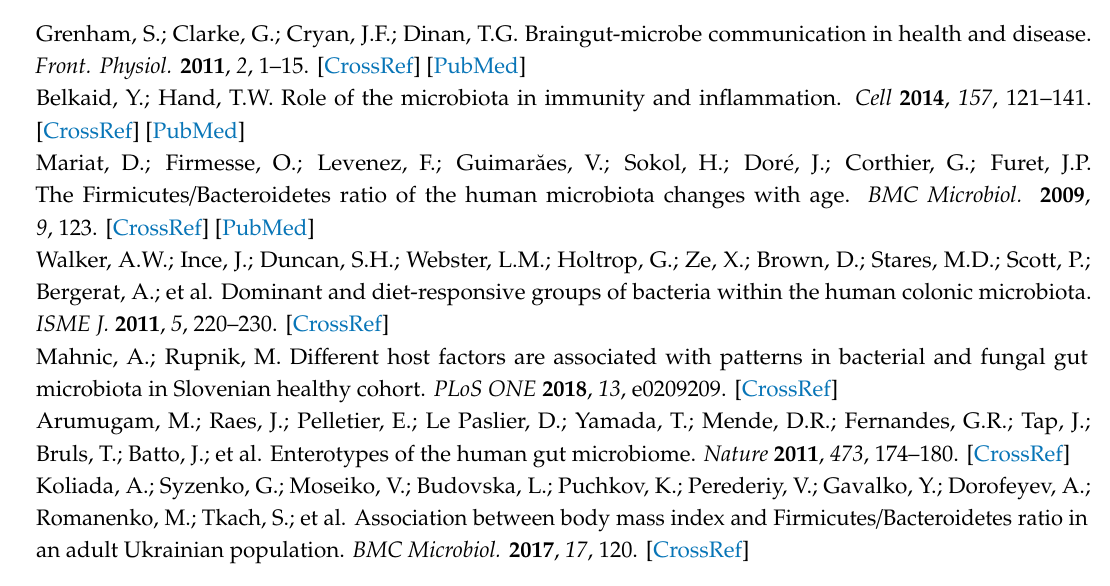
Table S1: Mean abundance values ± SD of bacterial genera from fecal samples categorized per BMI category of participants. * p < 0.05, Table S2: Mean abundance values ± SD of bacterial genera from fecal samples categorized per MD score of participants. * p < 0.05, Table S3: Mean abundance values ± SD of bacterial genera from fecal samples categorized per PA level of participants. * p <